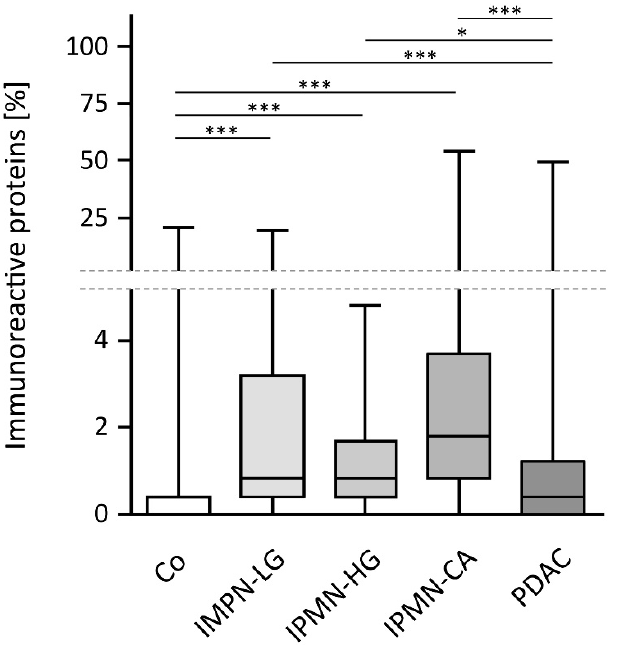
Figure 1. Proportion of immunoreactivity. While healthy controls (Co) and PDAC patients show the lowest proportions of immunoreactivity, no statistically significant difference between non-invasive (low- and high-grade) IPMN can be detected. IPMN with associated cancer (IPMN-CA) show the highest percentage of immunoreactivity. Statistical significance is computed based on Kruskal-Wallis test with Dunn’s post hoc test. The boxplot depicts boxes whose upper and lower hinges correspond to the 25th and 75th percentiles. Whiskers cover the range from lowest or highest observed value. Significance is superimposed where *** or * correspond to p -values < 0.001 or 0.05, respectively.